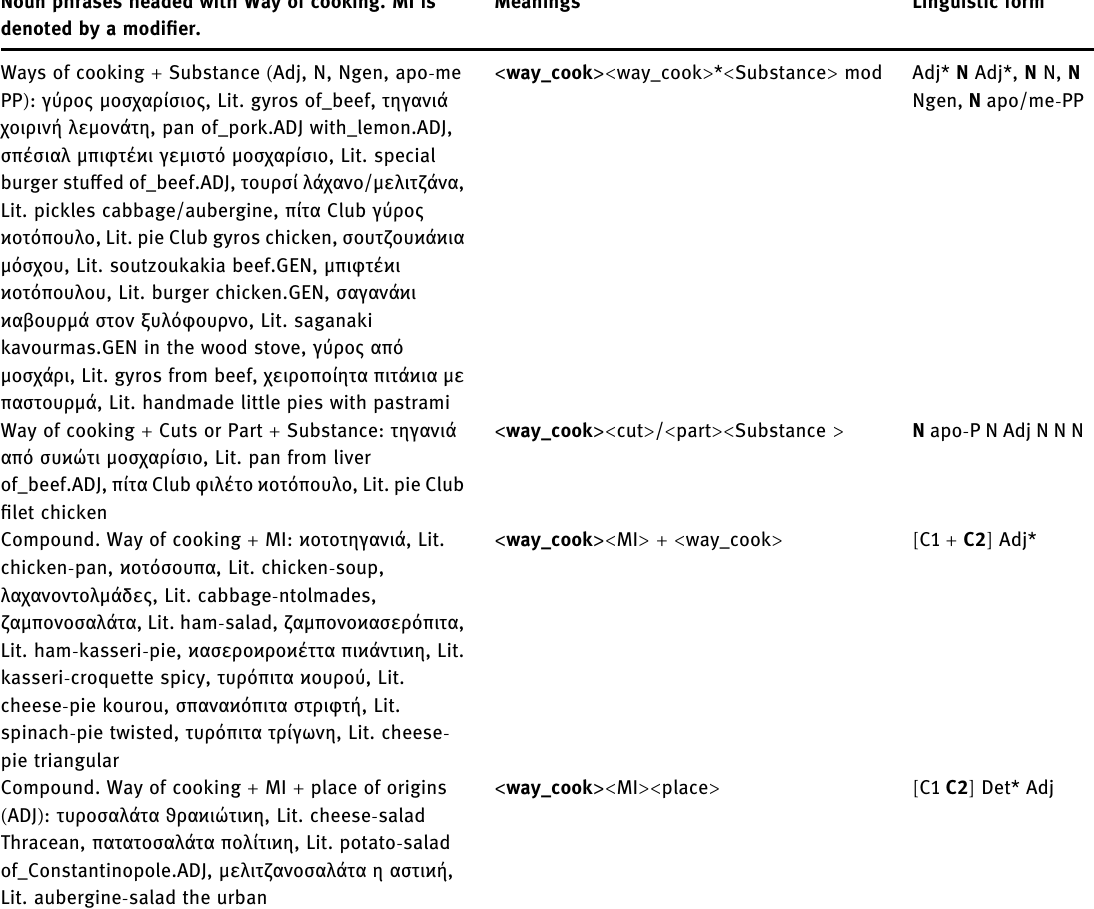
Table 7: The dish name is headed by a noun denoting the way of preparation, the Substance is denoted by a modi fi er of the head. The MI is entailed from or denoted by the substance Noun phrases headed with Way of cooking. MI is denoted by a modi fi